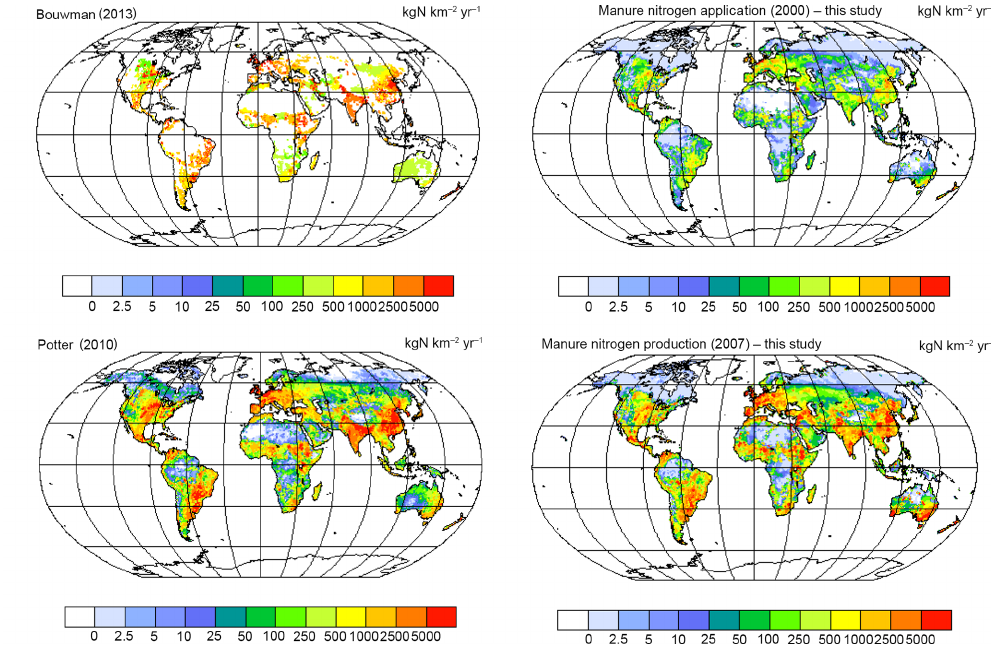
Figure 8. Comparison of manure nitrogen production estimated by Bouwman et al. (2013), Potter et al. (2010), and this